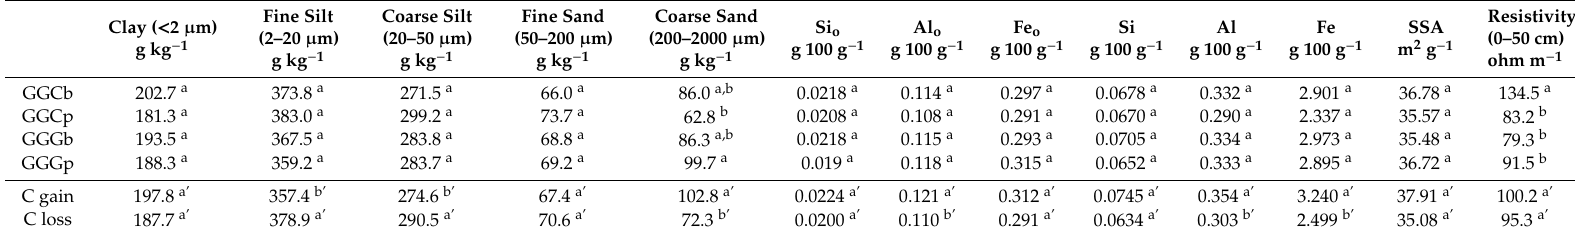
Table 5. Pedologic soil parameter measured for selected points (2014) in big plots (a) and predicted data for these points (b). Lowercase letter is statistical significance of the two-way ANOVA and Tukey’s HSD test: a, b and c for management treatments and a’ and b’ for C gain or loss points,